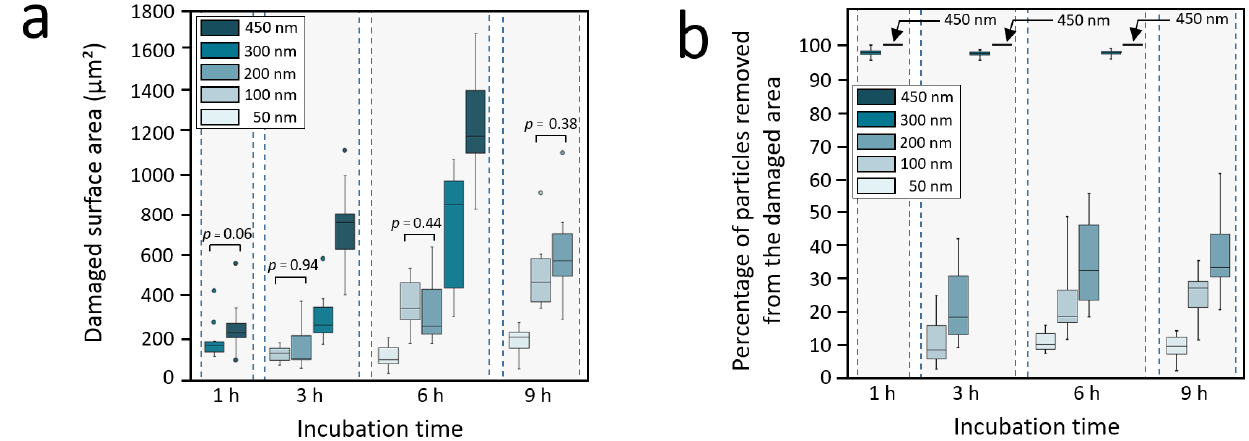
Figure 5. Quantification of the nanoparticle-based monolayer stability against macrophages. ( a ) Damaged surface area by a single cell as a function of time. ( b ) Percentage of NPs removed from the damaged area as a function of time. For a given incubation time, all the data are significantly different ( p < 0.05), except those for which a p is indicated (bilateral Mann-Whitney test).